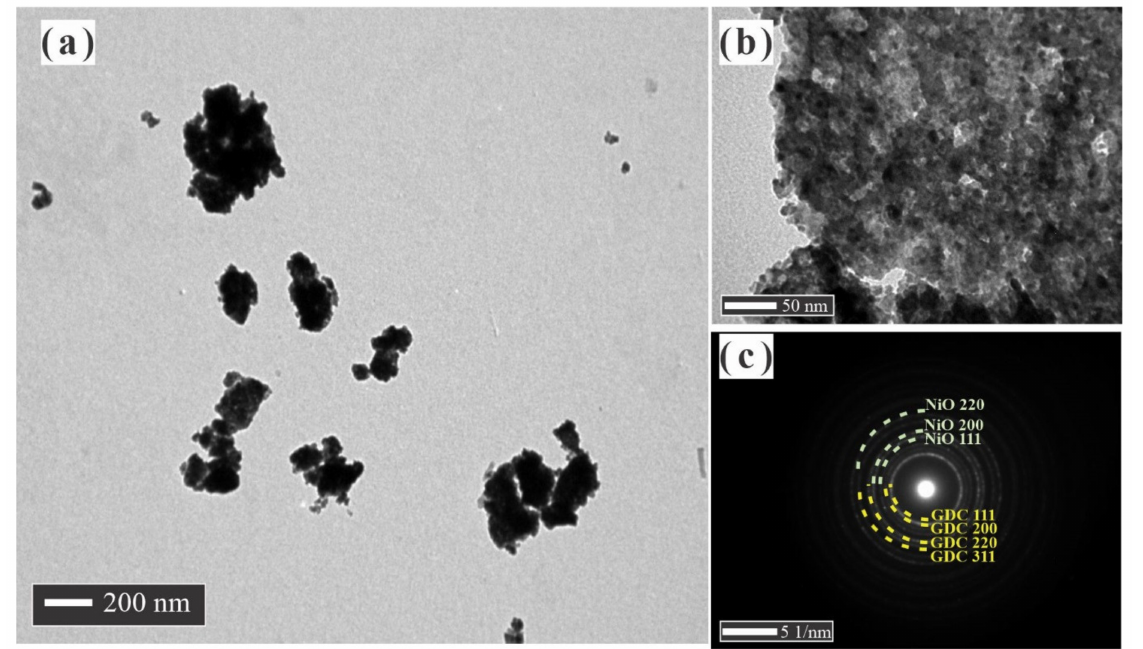
Figure 4. ( a , b ) TEM images and ( c ) SAED pattern of NiO-GDC nanocomposites obtained by CM method. The SEM images of the sintered discs microstructure obtained by the different methods used are shown in Figure 7. The dark grey and white phases correspond to NiO and GDC, respectively, and are easily distinguished using the BSE detector. As estimated, despite the high temperature and long-time conditions used in the sintering process, the three starting methods yield different microstructures with highly dispersed and